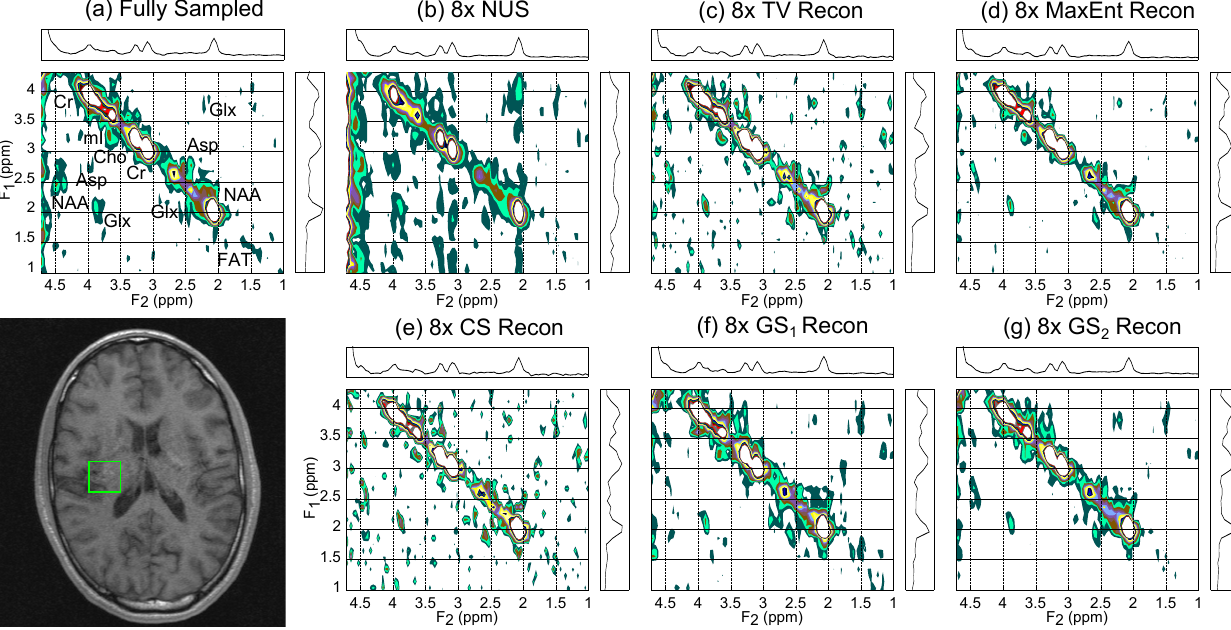
Figure 4. Select 2D COSY in vivo spectrum from a central 2 × 2 × 2 cm 3 voxel of the brain from the ( a ) fully sampled 4D EP-COSI scan of a healthy 23 year old male ( b ) 8 × NUS and the ( c ) 8 × TV ( d ) 8 × MaxEnt ( e ) 8 × CS ( f ) 8 × GS